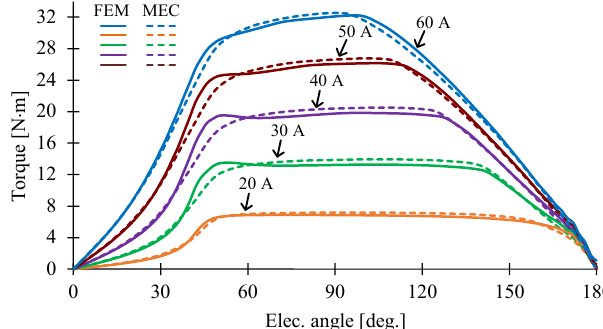
Figure 18. Static torque characteristics at different